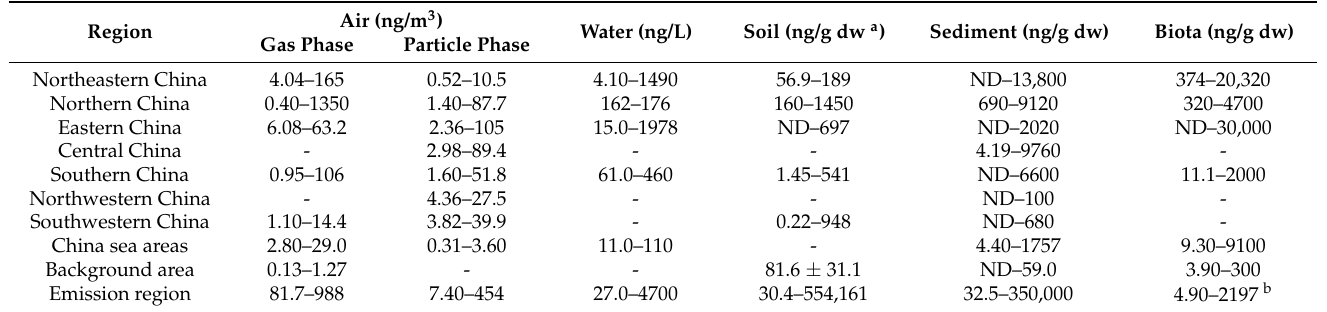
Table 1. Concentrations of SCCPs in air, water, soil, sediment and biota samples collected from different regions of